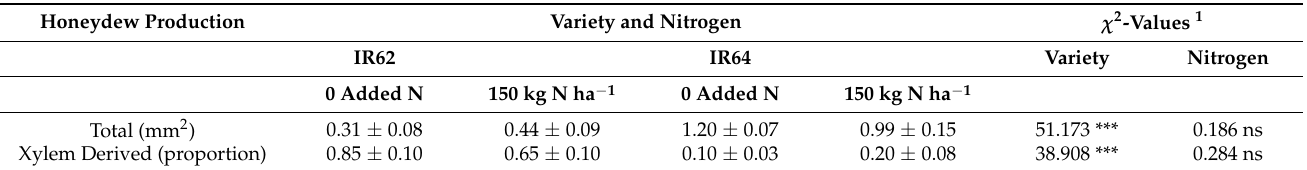
Table 1. Honeydew production by BPH on IR64 (susceptible) and IR62 (resistant) rice plants. Num- bers are means ± SEM (N =